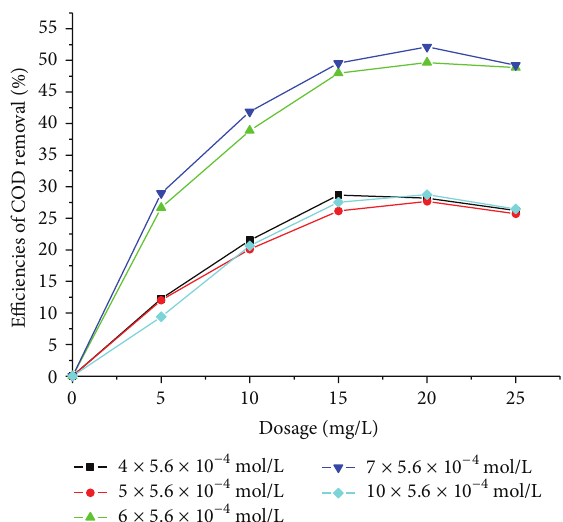
Figure 9: Effects of concentration of monomers on turbidity removal for sewage.